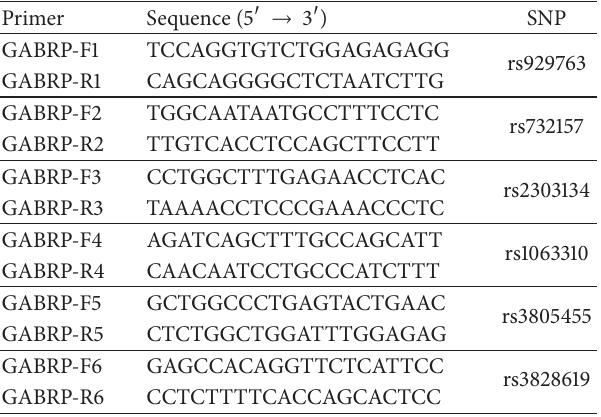
Table 1: Primer sequences used for genotyping of GABRP